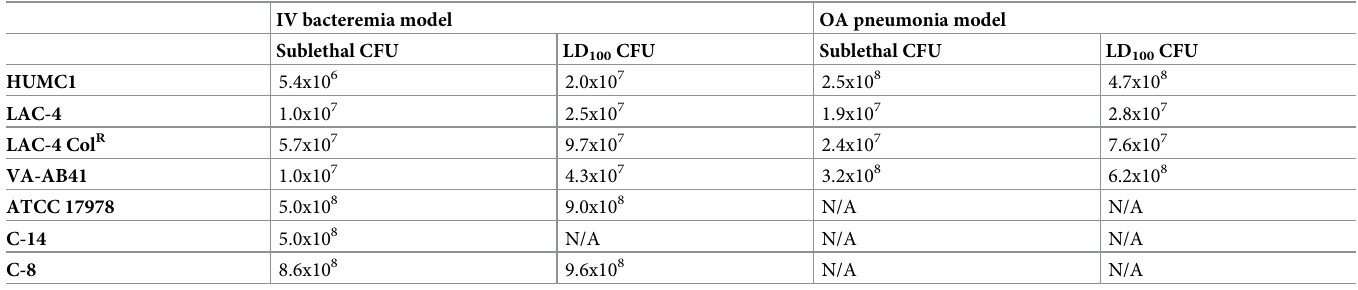
Table 2. LD100s of A . baumannii Isolates 1